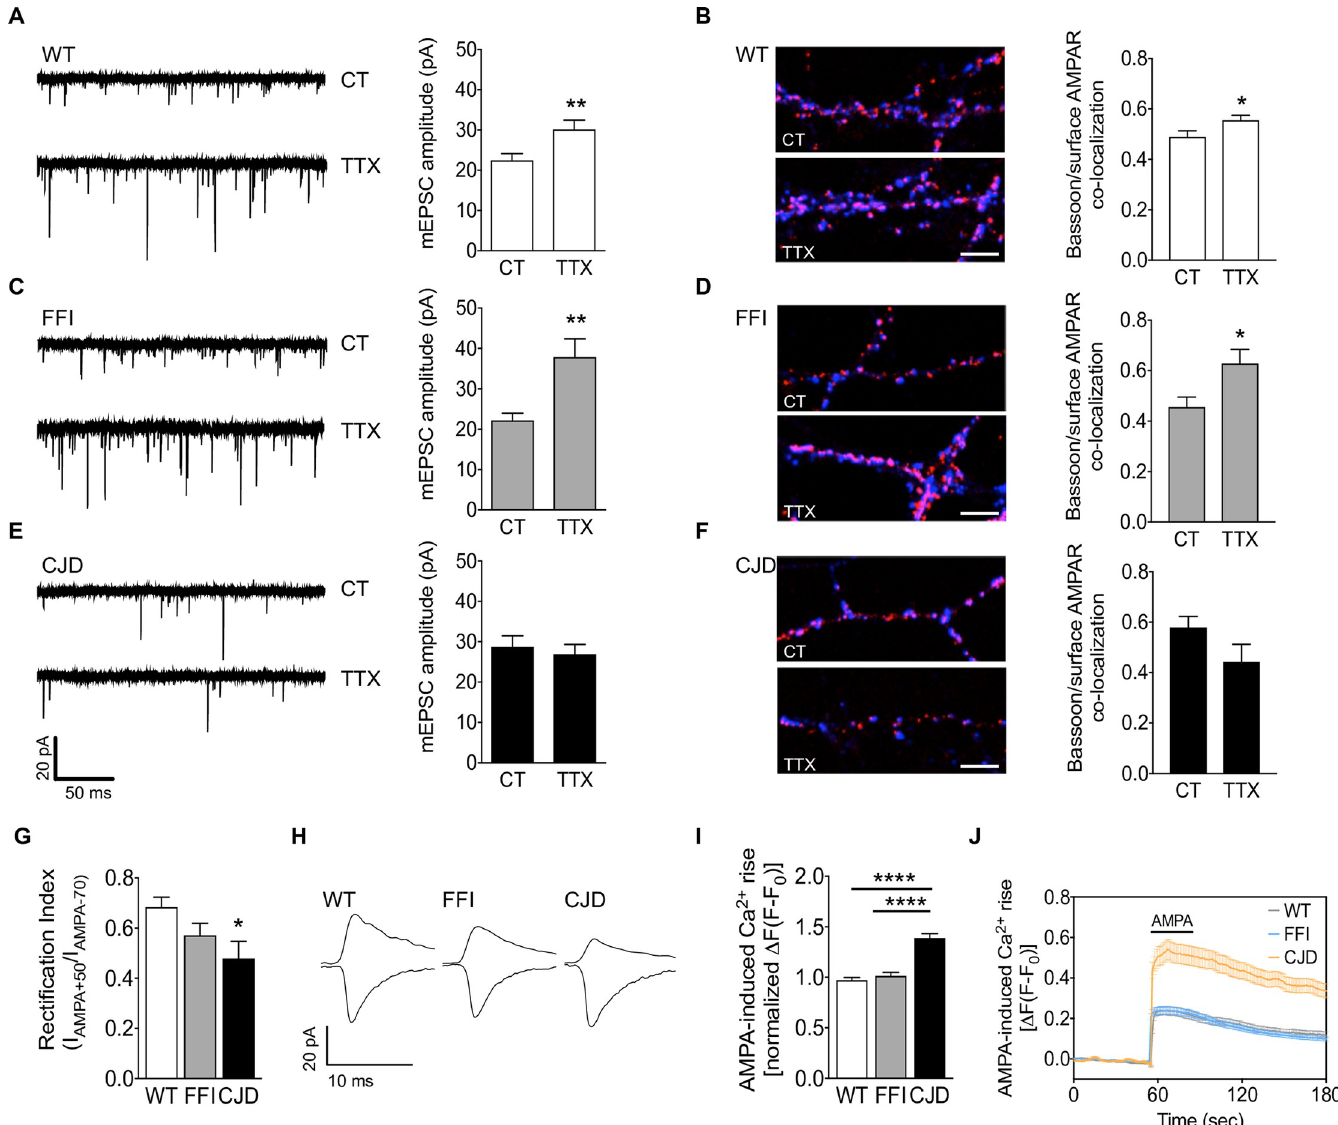
Fig 3. AMPA receptor trafficking is impaired in CJD but not in FFI neurons. (A, C, E) Representative traces and quantification of mEPSC amplitude in control and TTX-treated WT, FFI and CJD neurons. WT 16 (CT) and 18 (TTX), FFI 12 (CT) and 13 (TTX), CJD 18 (CT) and 16 (TTX) cells. Mann-Whitney test: �� p < 0.01. (B, D, F) Confocal representative images and quantification of the levels of co-localization between Bassoon (blue) and surface AMPAR (red) in the conditions described above. Scale bar 5 μ m. Unpaired Student’s t-test: � p < 0.05. (G) Rectification index (I AMPA+50 /I AMPA-70 ) and (H) representative traces in WT and mutant neurons. WT 24, FFI 15, CJD 7 cells. Kruskal-Wallis test followed by Dunn’s multiple comparison test: � p < 0.05. (I) Analysis of calcium peaks and (J) representative traces of calcium response to AMPA (30 μ M) in WT, FFI and CJD neurons. Six fields (79–150 responding cells) for each condition. Kruskal-Wallis test followed by Dunn’s multiple comparison test: ���� p < 0.0001. Data are the mean ± SEM of at least three independent experiments.